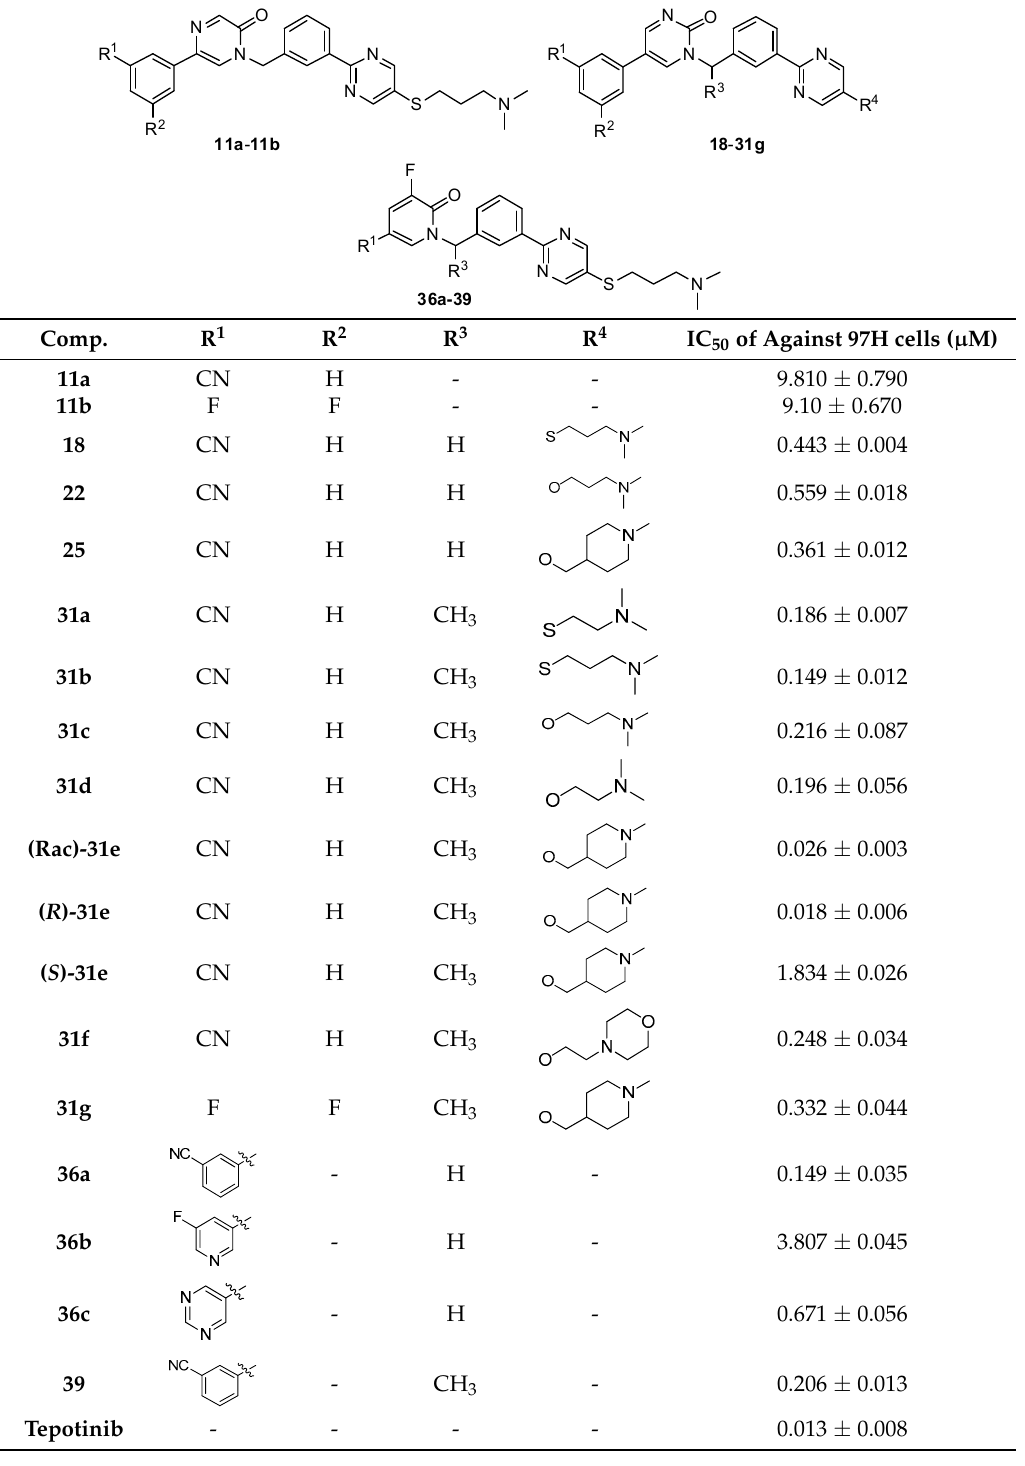
Table 1. Structures and antiproliferative activity of target